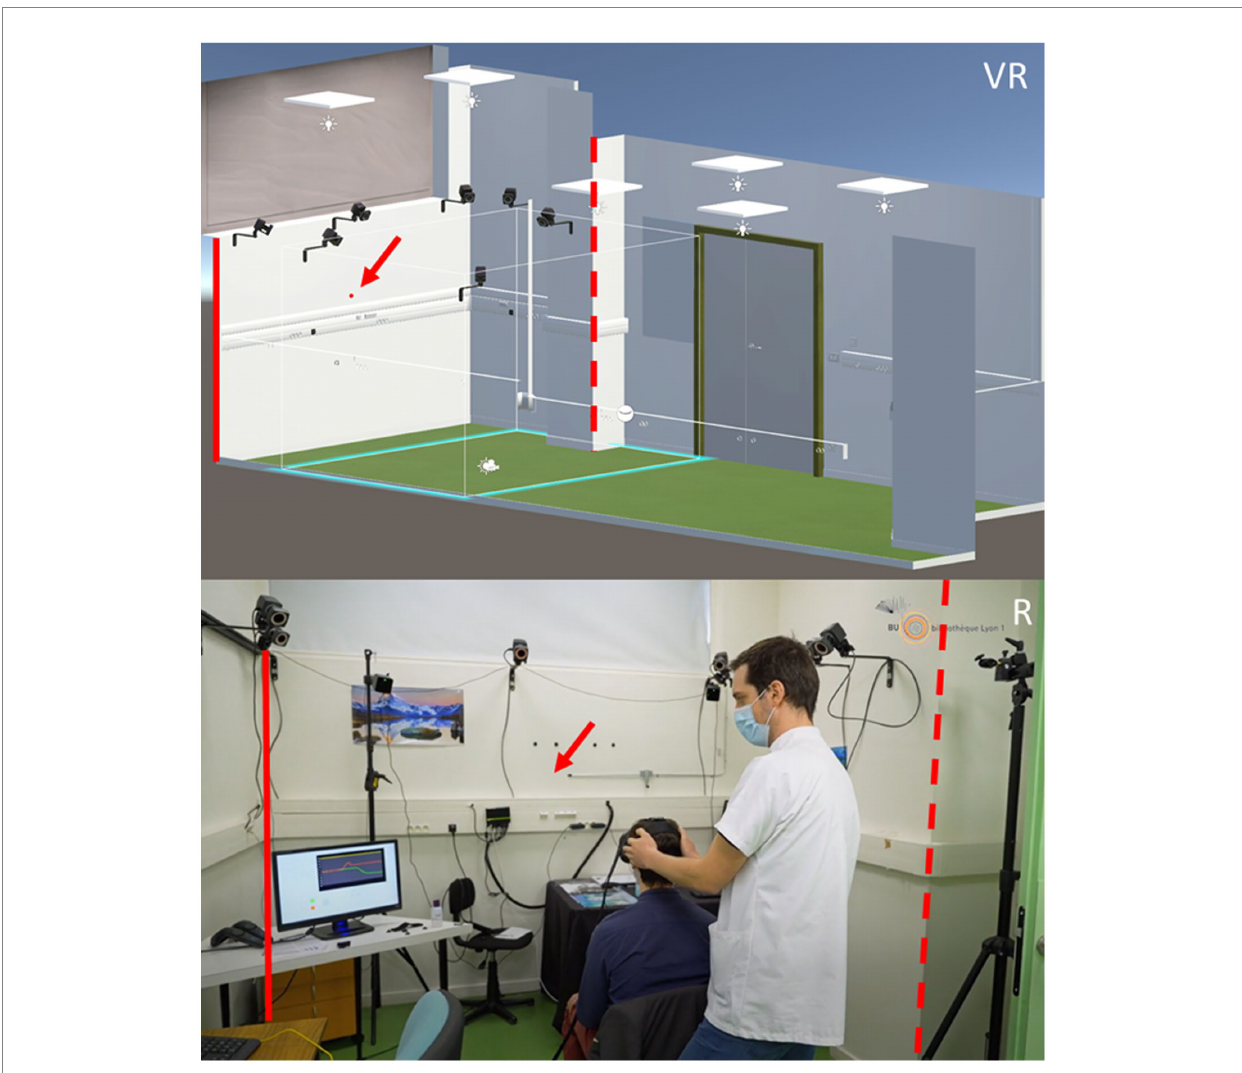
FIGURE 1 Simulated environment in virtual reality (VR) and picture of the real room (R) where the virtual reality experiments were performed. The size of the real room as well as some of its features (doors, cameras, power plugs…) were faithfully represented in the VR environment. The full and dotted red line are placed on the same corners in the virtual and real room to help comparisons. The red arrow points to where the fixation point is (VR) or should be